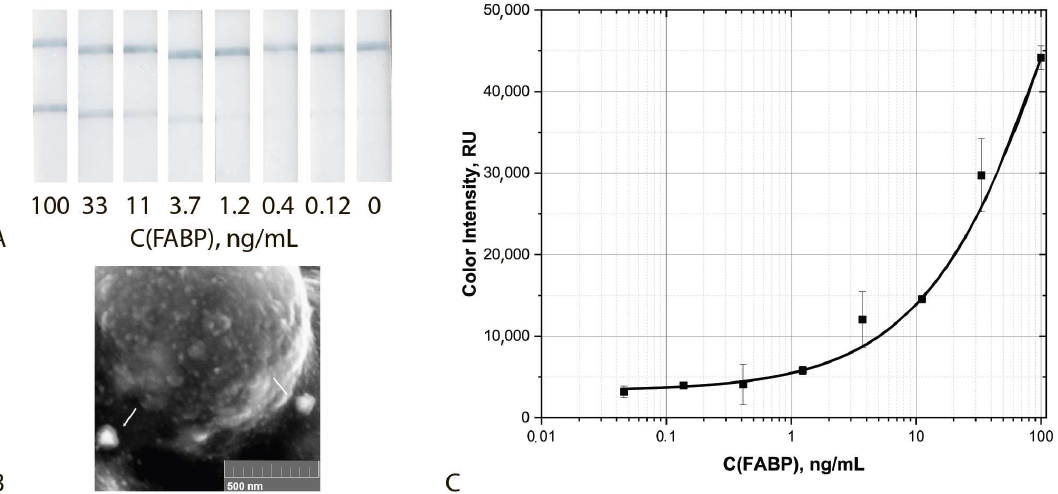
Figure 7. ICA with the use of GNFs: Appearance of test strips ( A ), SEM image of the GNFs bound in the analytical zone ( B ) and calibration curve for FABP detection in serum ( C ) (n = 5).